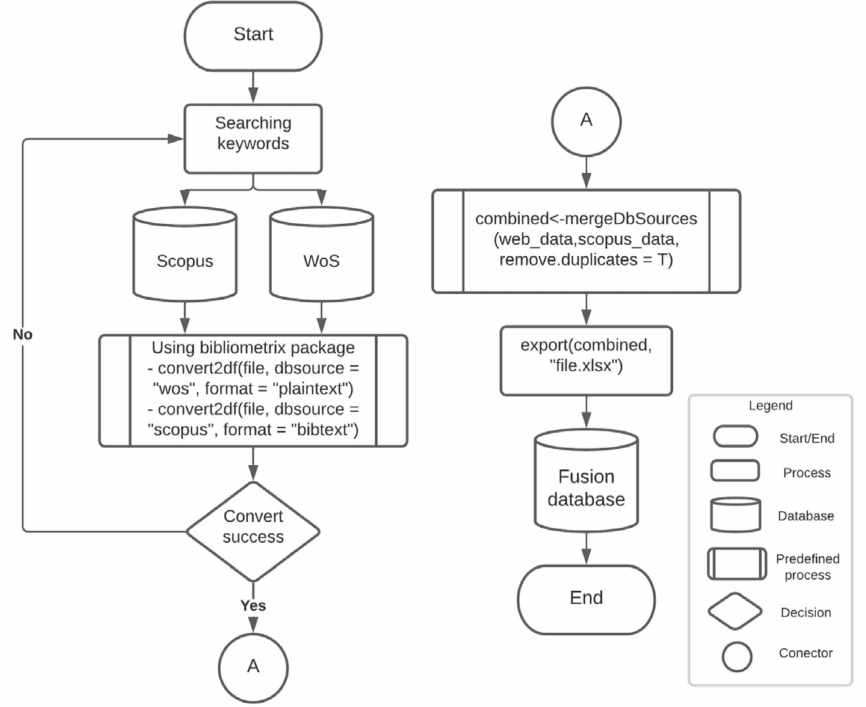
Figure 2. The flowchart of Bibliometrix (RStudio) instructions for merging WoS and Scopus